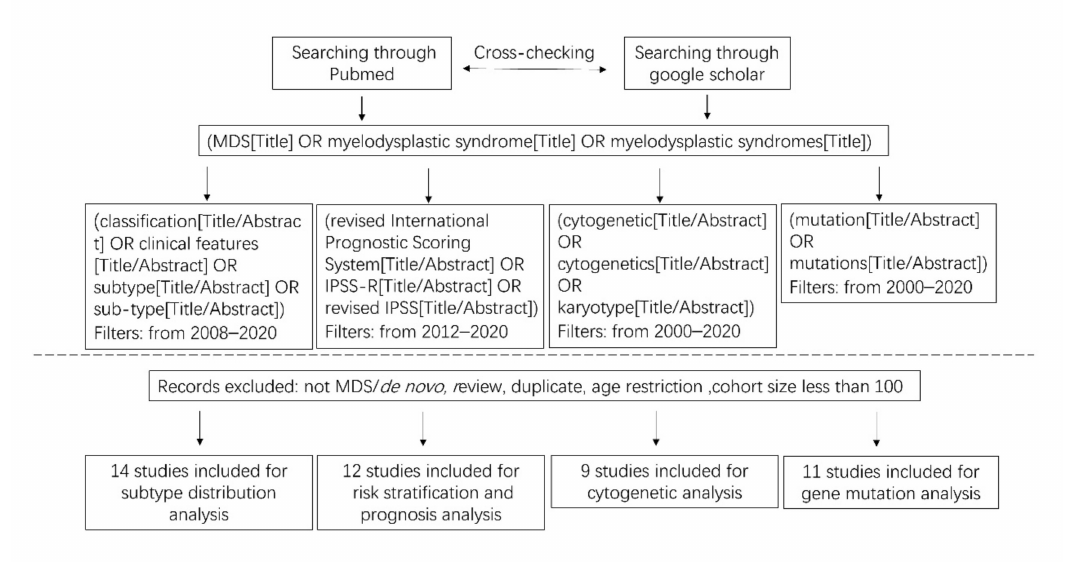
Figure 3. Flow chart for the process of identifying studies included in and excluded from the systematic review for the comparisons of MDS subtypes, risk stratification and prognosis, cytogenetic abnormalities, and gene